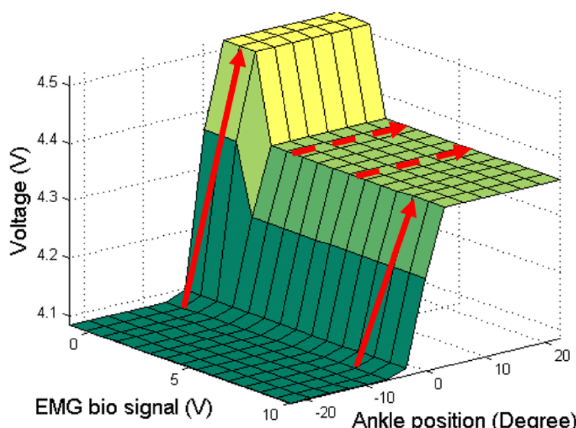
Figure 2: The fuzzy surface of the PICAFO FC shows the non-linearity between EMG, ankle position, and damping stiffness